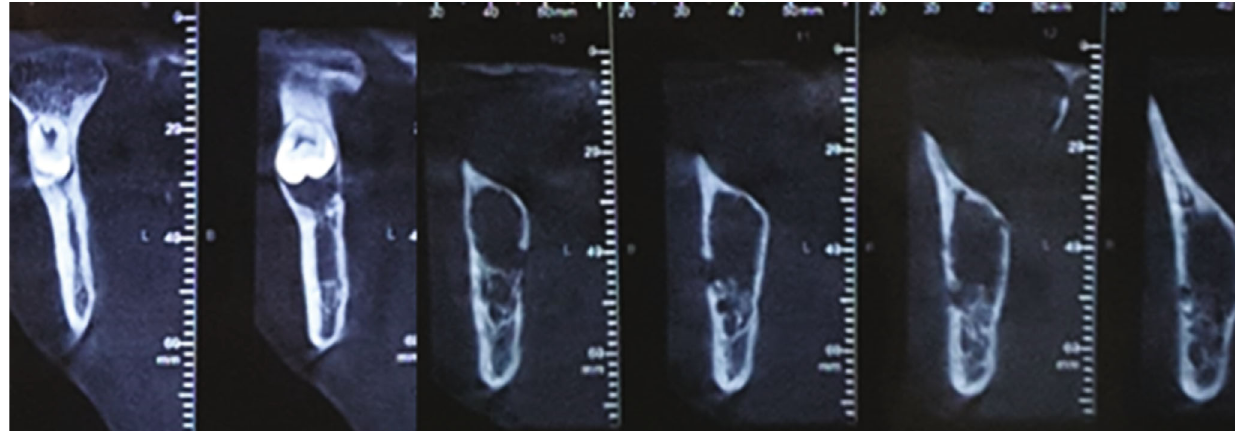
Figure 13: Coronal